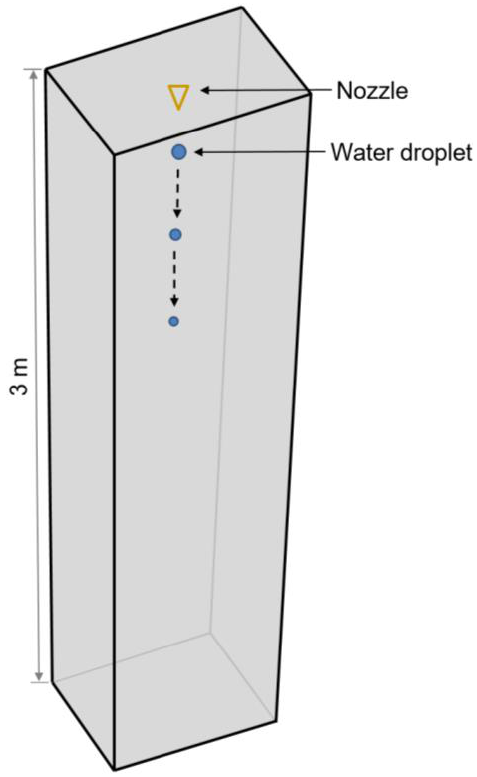
Figure 1. Schematic of the computational domain for the movement of droplet.